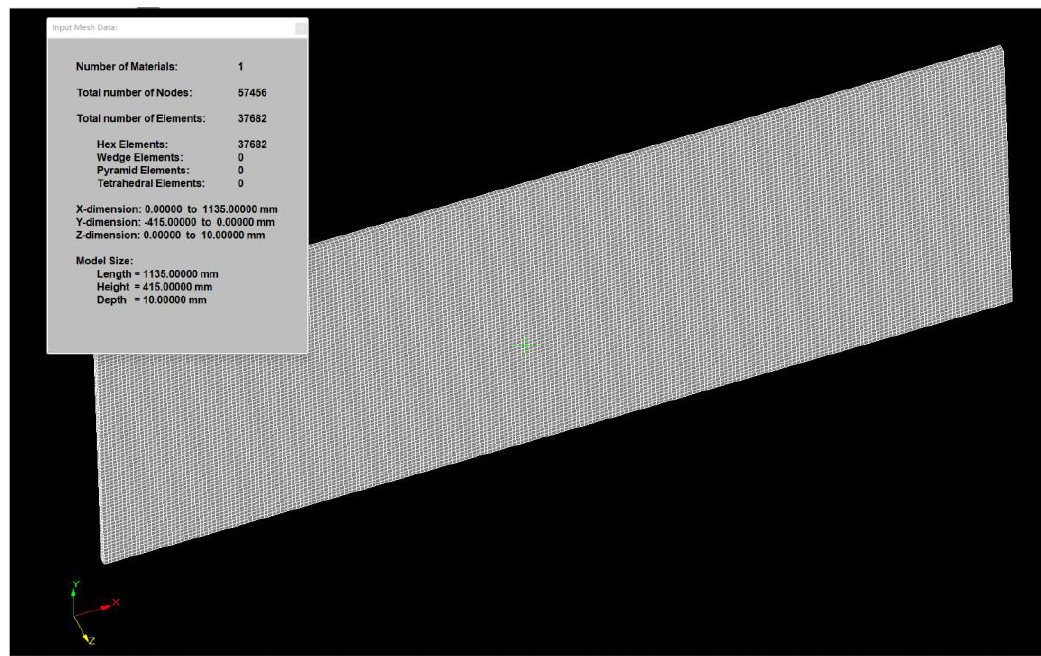
Figure 1. Information about geometric